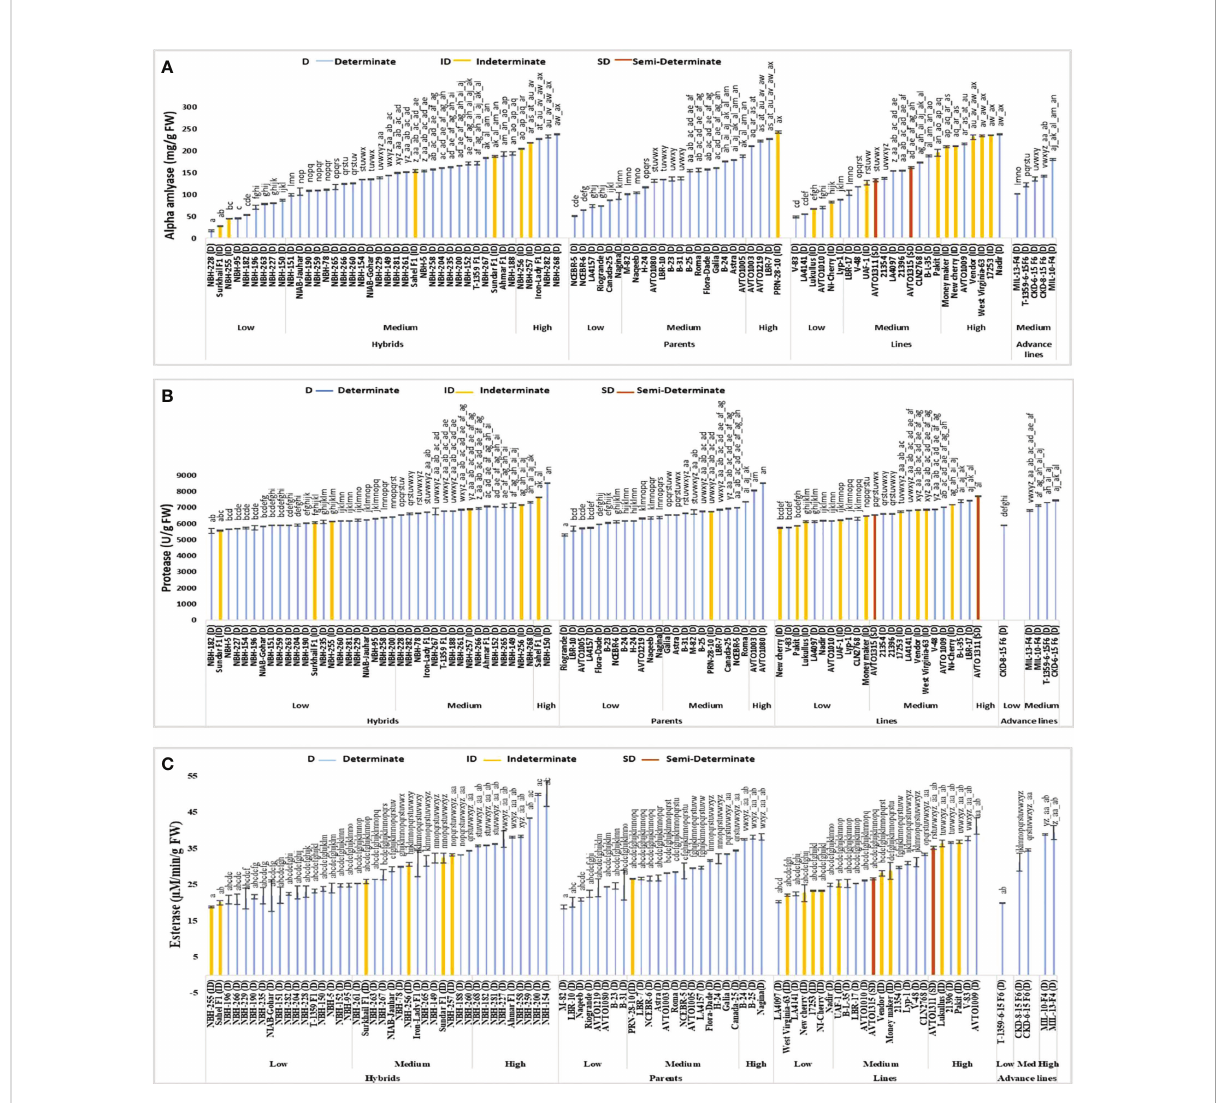
FIGURE 5 Comparison of fruit (A) alpha-amylase, (B) protease, and (C) esterase activities in different tomato genotypes (mean value ± SD). Mean value with varying alphabet differs signi fi cantly (p < 0.05, Tukey ’ s